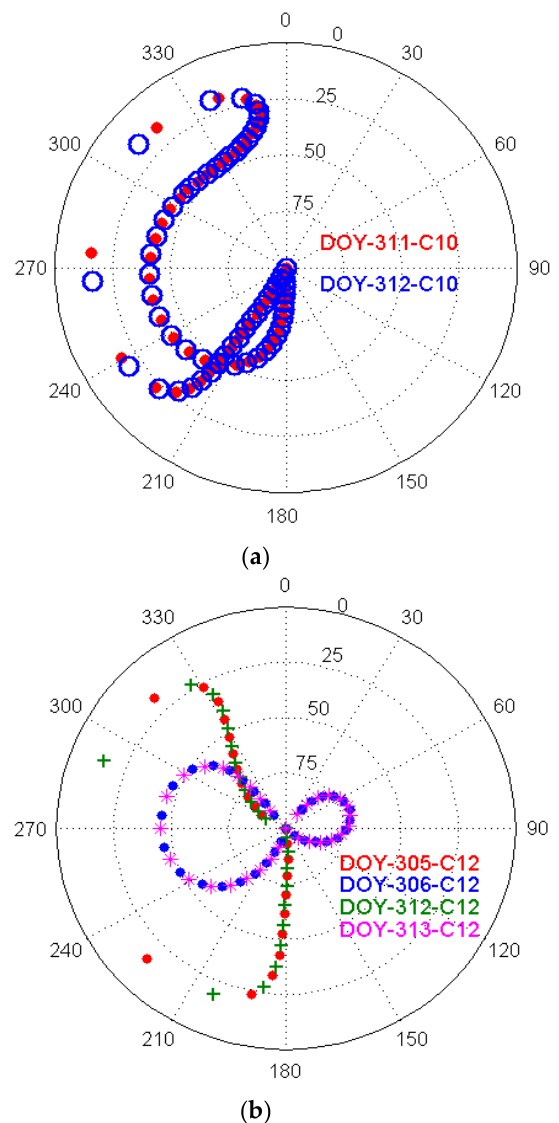
Figure 3. Trajectory of C03 for day of the year (DOY) 311-313 in the elevation and azimuth domain.